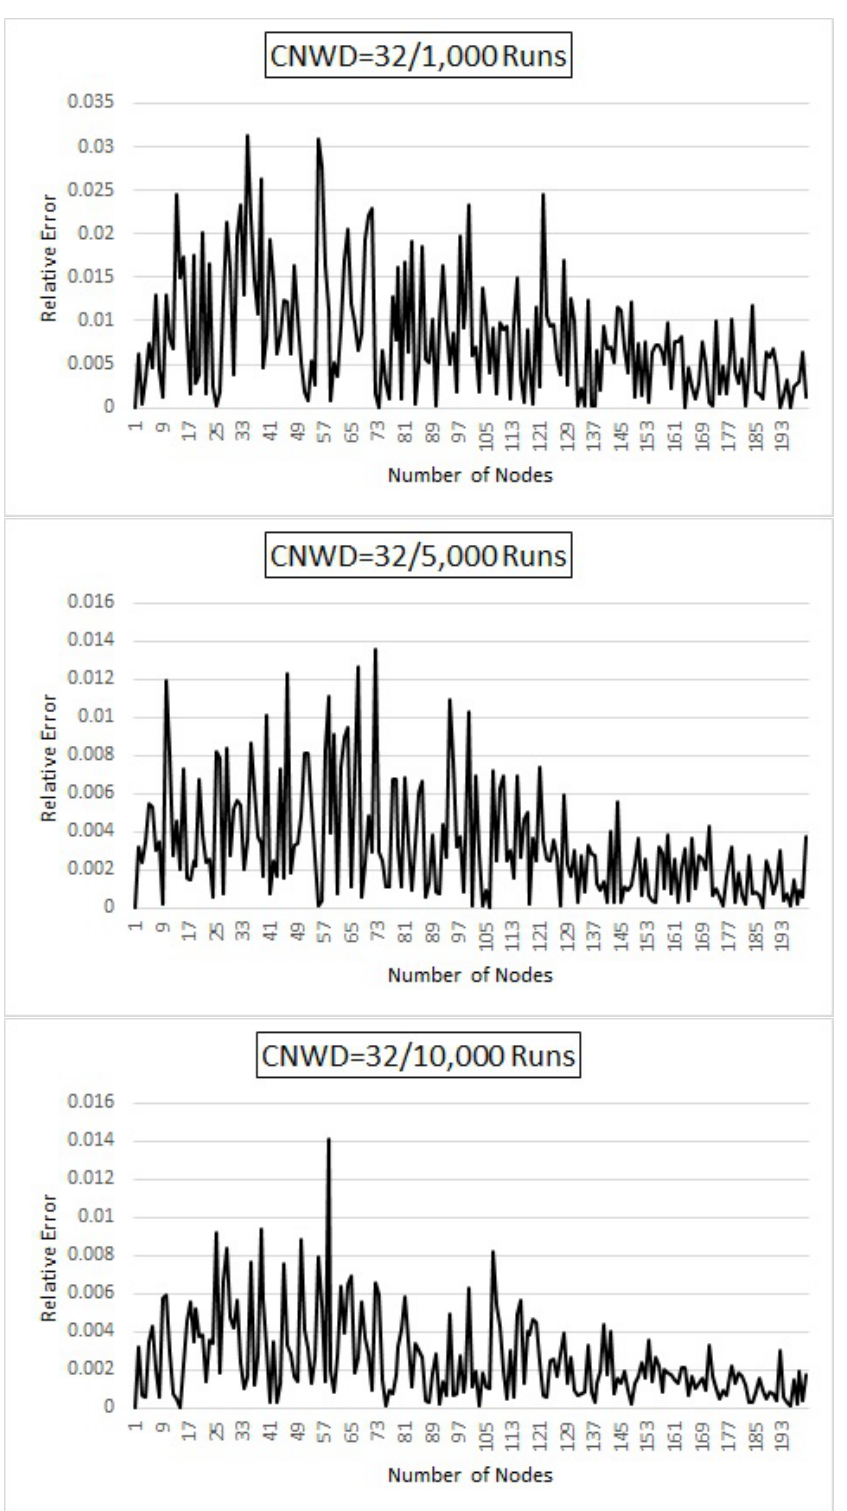
Figure 5. Theoretical vs. Simulated results for CNWD =